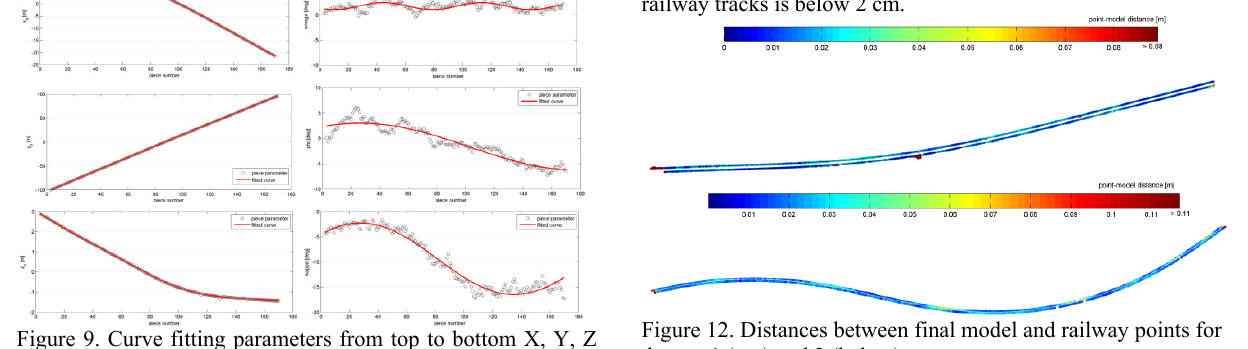
Figure 9. Curve fitting parameters from top to bottom X, Y, Z (left) and omega, phi and kappa (right).